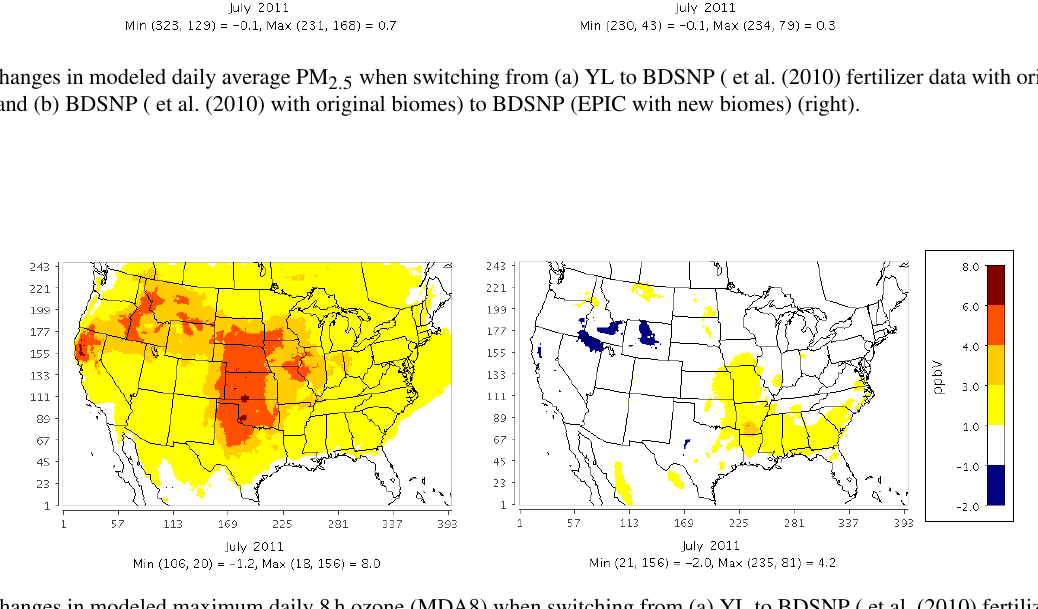
Figure 9. Changes in modeled maximum daily 8h ozone (MDA8) when switching from (a) YL to BDSNP ( et al. (2010) fertilizer data with original biome map) (left) and (b) BDSNP ( et al. (2010) with original biomes) to BDSNP (EPIC with new biomes) (right).